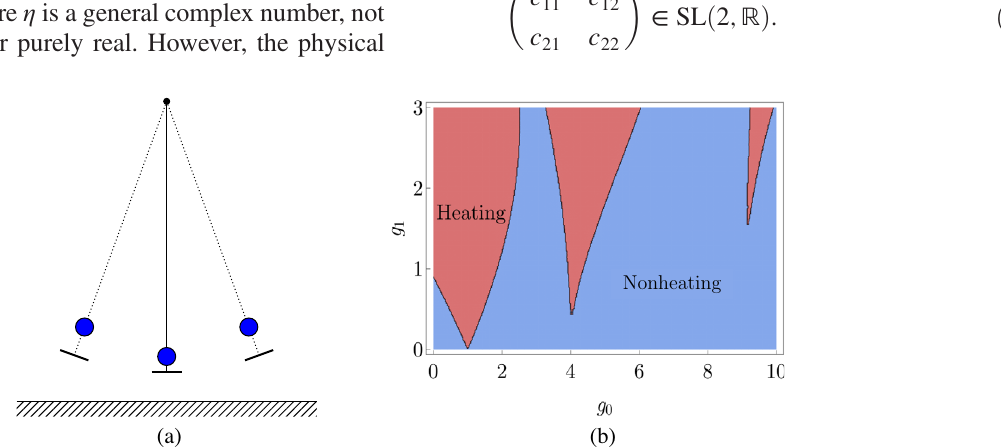
FIG. 4. (a) A simple example of a Mathieu oscillator is a child pumping a swing by periodically standing and squatting to increase the amplitude of the oscillation. The pump motion of a skilled child is typically at twice the frequency of the swing ’ s oscillations which belongs to the heating phase. (b) Phase diagram of a Mathieu oscillator. In the red regime, energy keeps growing exponentially. In the blue regime, energy only oscillates. The black curve corresponds to the phase boundary, where energy grows